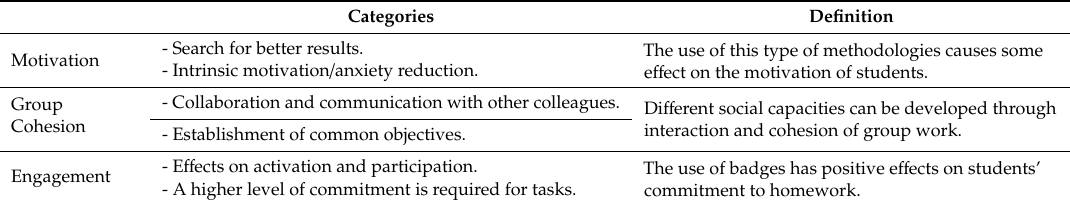
Table 5. The categories obtained after interpreting the answers.